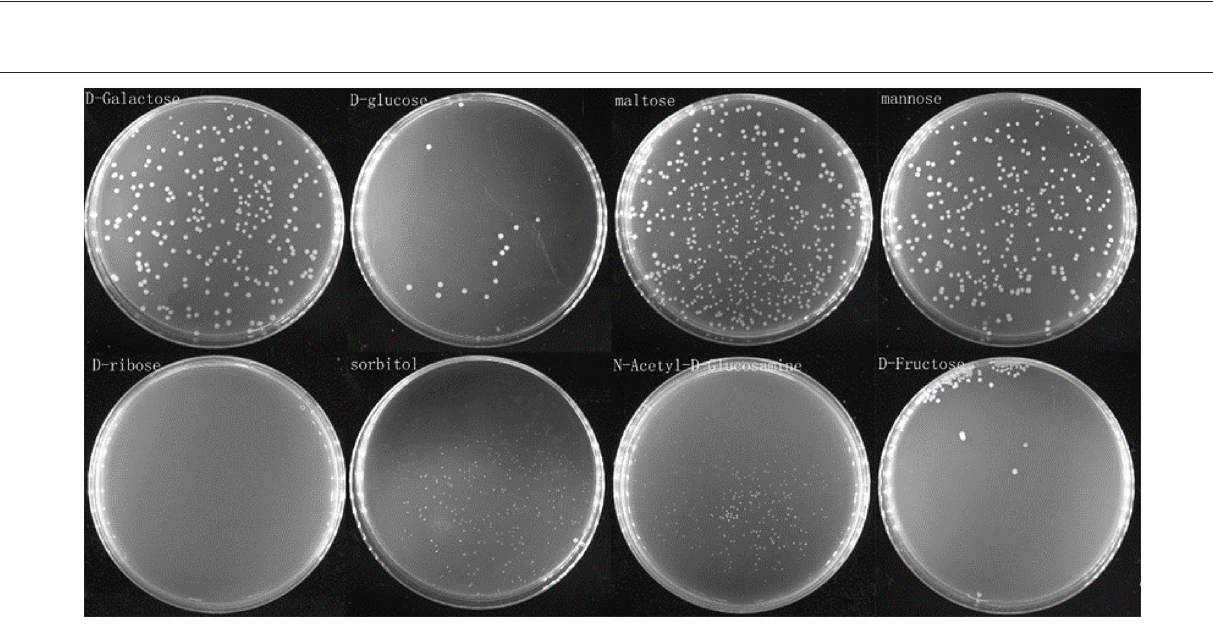
FIGURE 5 | Persister cells wake up on plate containing single saccharide. Persister cells were spread on M9 minimal plates with D-glucose, D-fructose, D-ribose, N-acetyl-D-glucosamine, D-galactose, mannose, maltose, and sorbitol, respectively. The concentration of each saccharide on the plate was 0.4%, and the plates were incubated at 28 ◦ C for